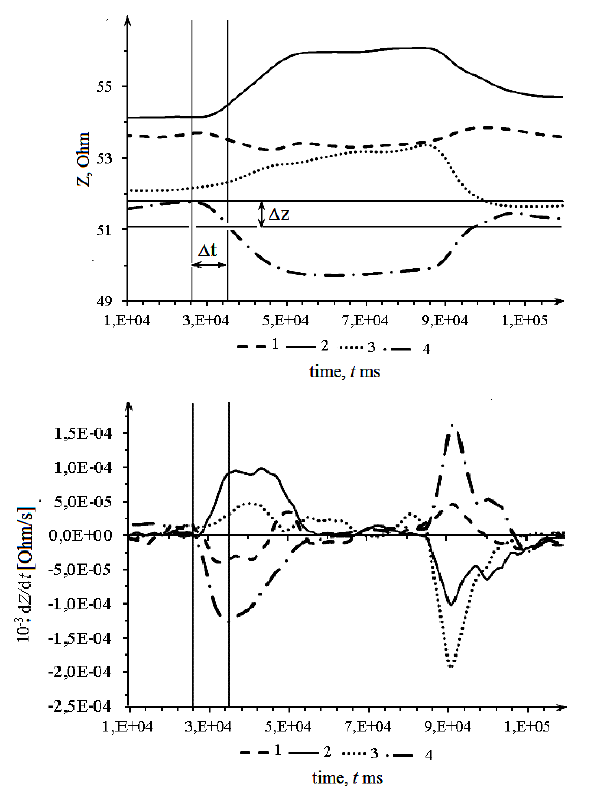
Fig. 7: The impedance signals obtained by electrode system.